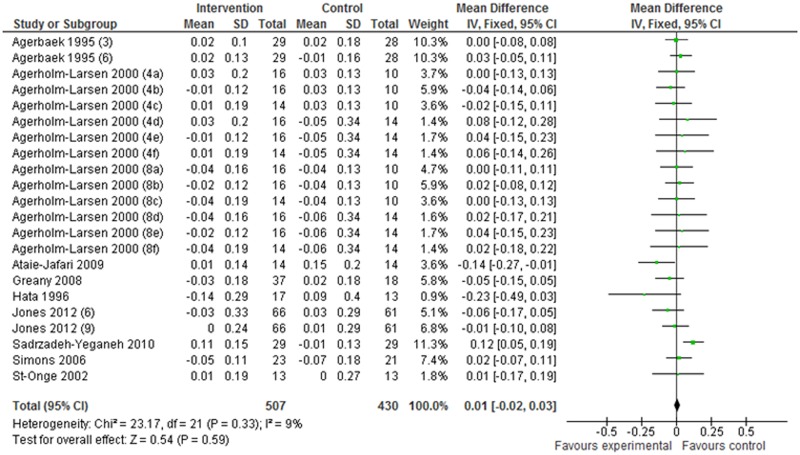
Effects of probiotics on changes in serum HDL-C levels.Values in parentheses indicate intake duration (weeks). a, b, and c in parentheses indicate Gaio, Stra, and StLa vs PP, respectively; d, e, and f in parentheses indicate Gaio, Stra, and StLa vs PY, respectively. PP: placebo pill; PY: placebo yogurt; StLa: Streptococcus thermophilus and Lactobacillus acidophilus; StLr: Streptococcus thermophilus and Lactobacillus rhamnosus.